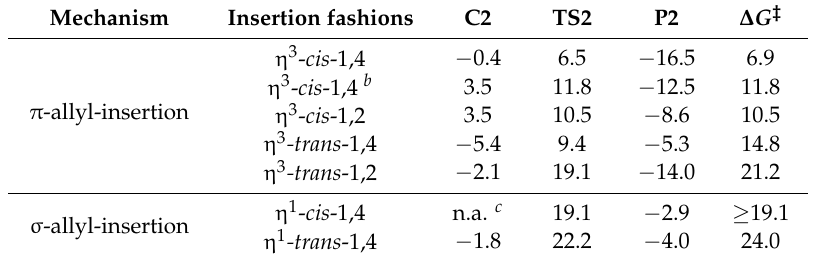
Table 2. Energy Profiles a for insertion of the second butadiene into the metal–butenyl bond of P1 cis . Mechanism